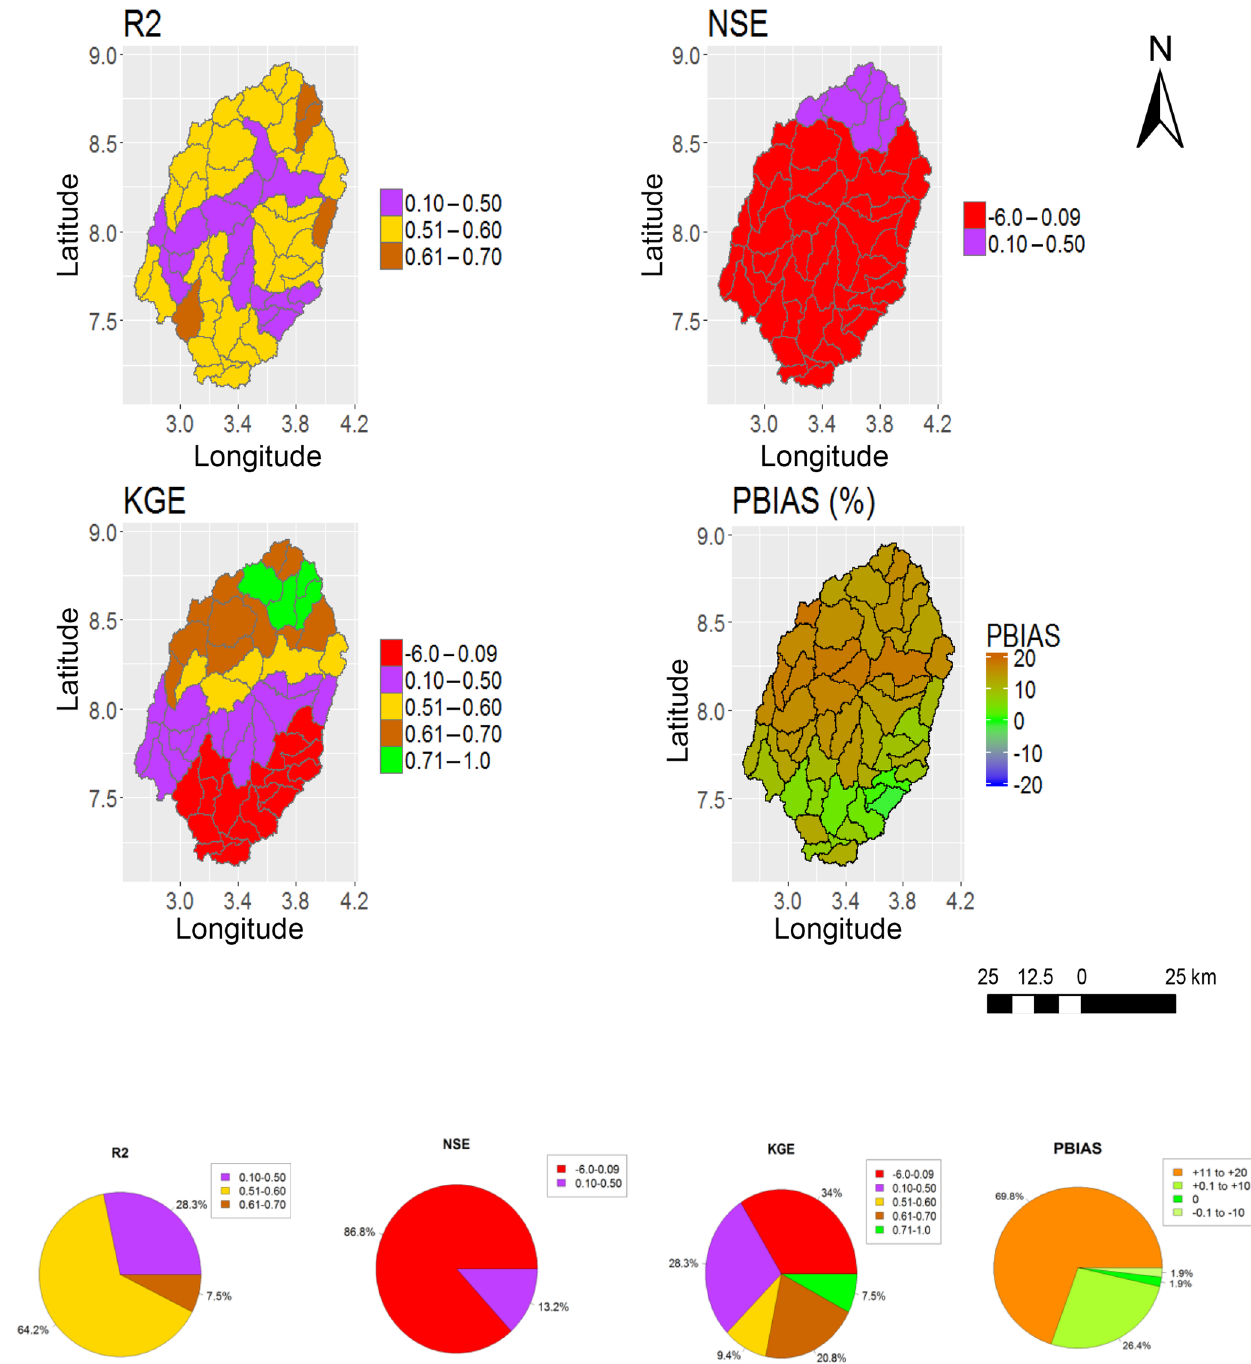
Figure 7. Performance metric (NSE, KGE, R 2 and PBIAS) results of SWAT (SWAT_P-M) when validated with MOD16